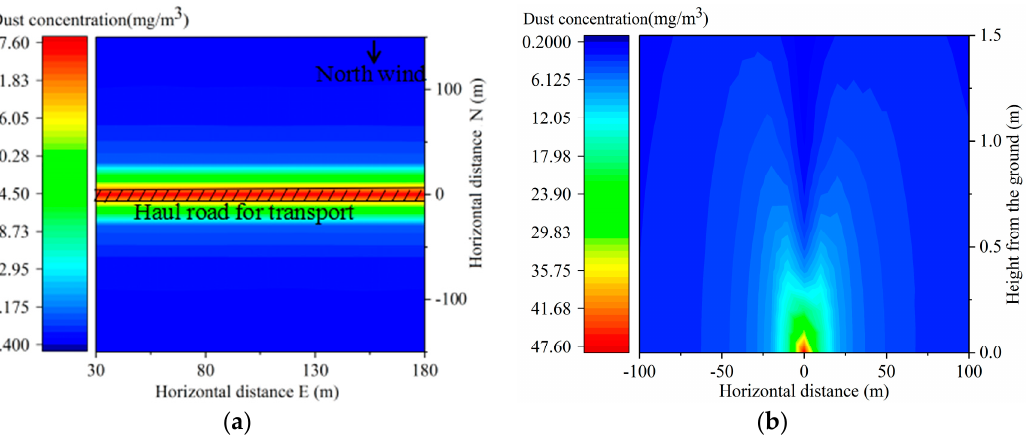
Figure 4. Spatial distribution of dust concentration in road transportation ( a ) is in horizontal direction, and ( b ) is in vertical direction).